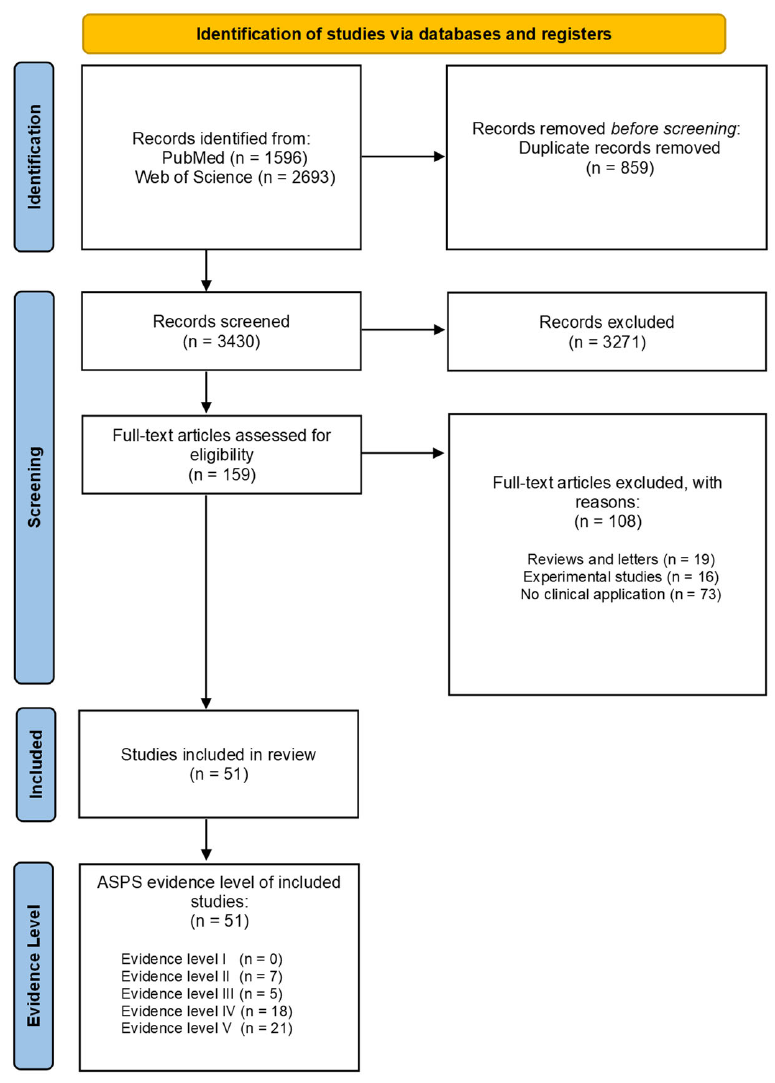
Figure 2. Modified PRISMA Flow Diagram. PRISMA: Preferred Reporting Items for Systematic Reviews and Meta-Analyses. ASPS: Evidence Rating Scales of the American Society of Plastic Surgeons.